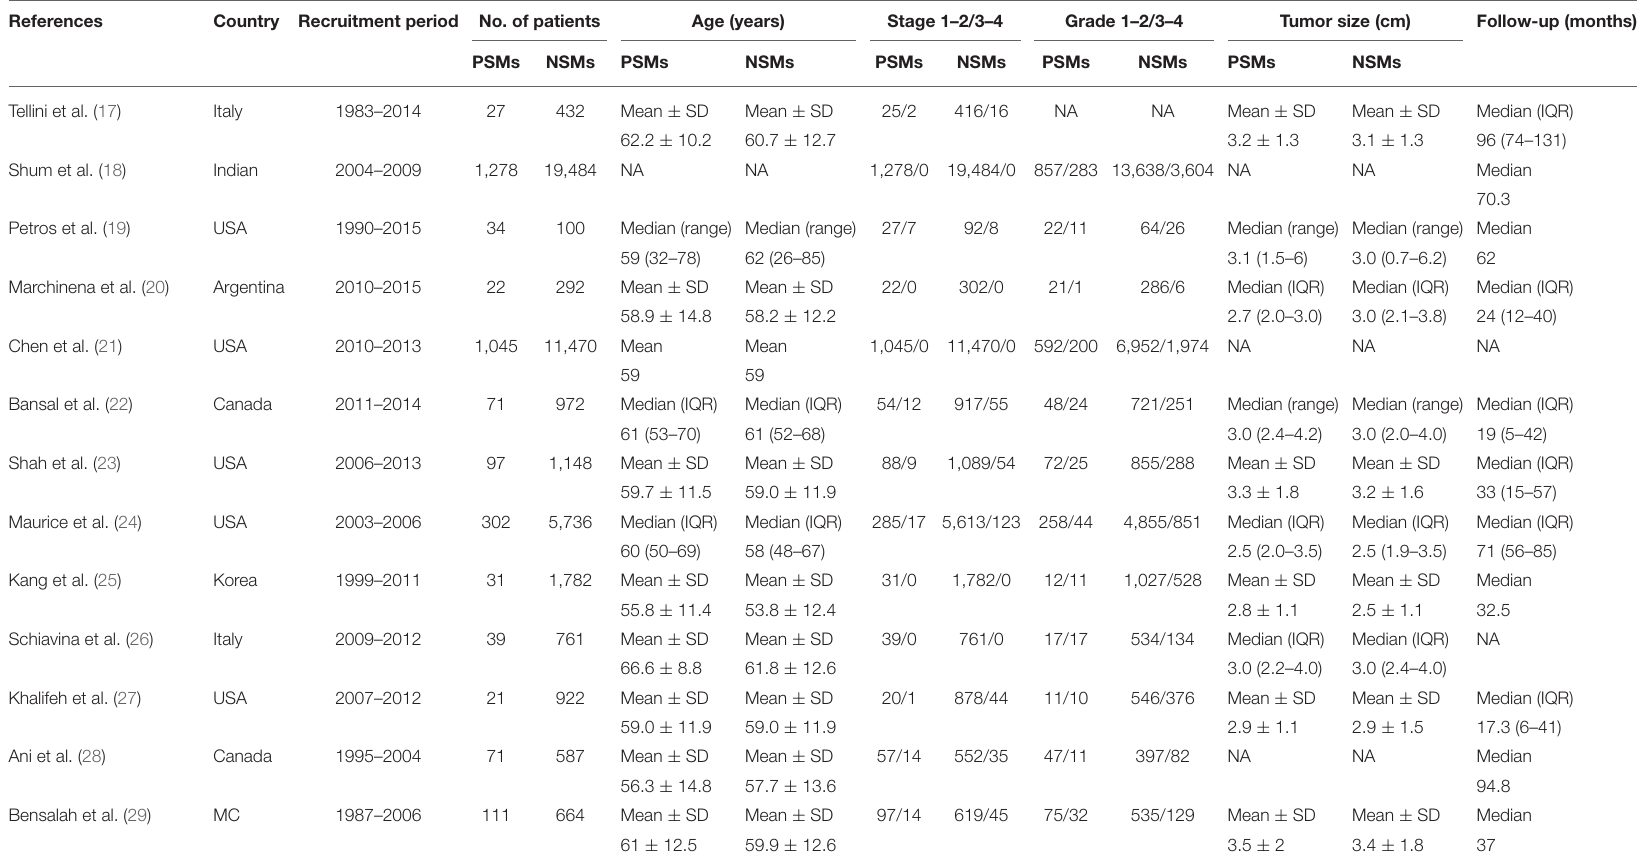
TABLE 1 | The main clinicopathological characteristics of all studies included in this